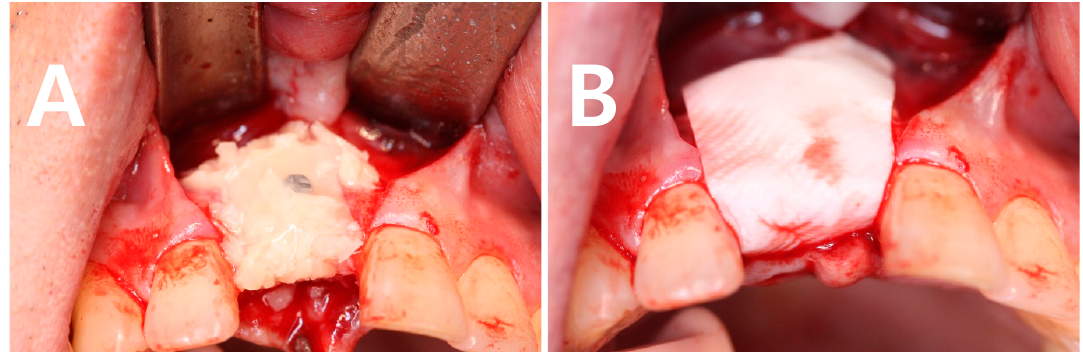
Figure 1. Clinical photographs of the procedure of a mandibular block bone graft for augmentation of an atrophic alveolar bone. ( A ) Fibrin glue was applied to the grafted bone, the block bone was secured with titanium miniscrew and the particulated bone was filled around the block bone. ( B ) collagen-based membranes (CBM) was used on the graft site after trimming of the grafted bone.